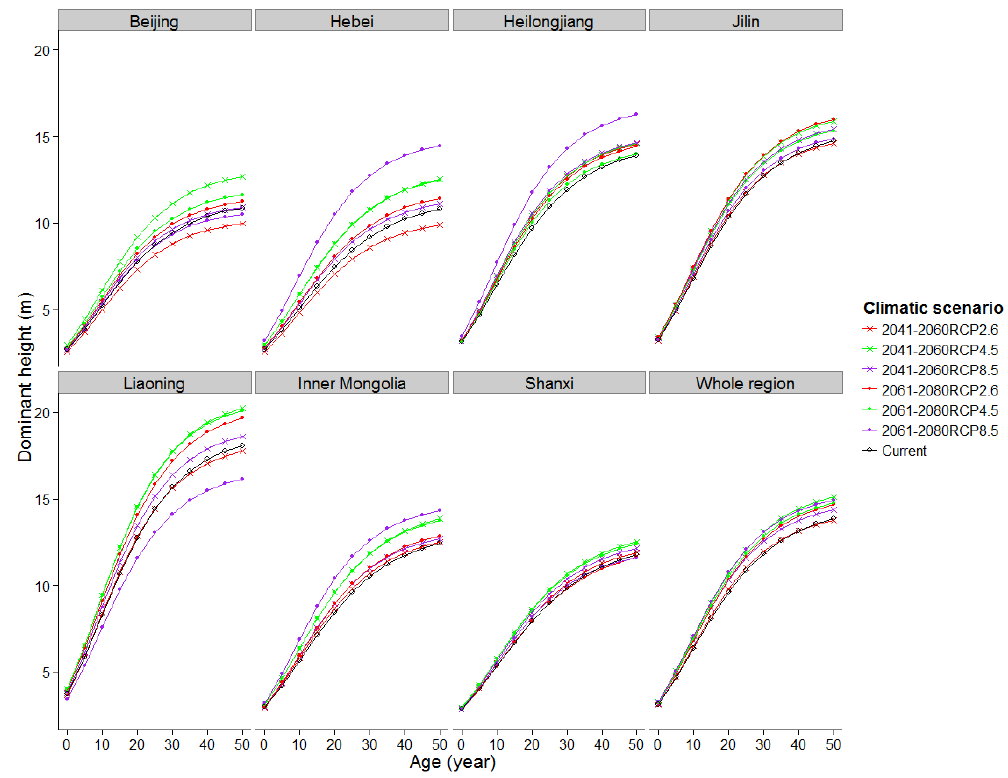
Figure 5. The dominant height profiles generated using the average values of all climate variables in 303 different provinces and under different climatic scenarios. 304 Table 4. Predicted dominant height difference under future climate scenarios at different stages and 305 under different climate scenarios. 306